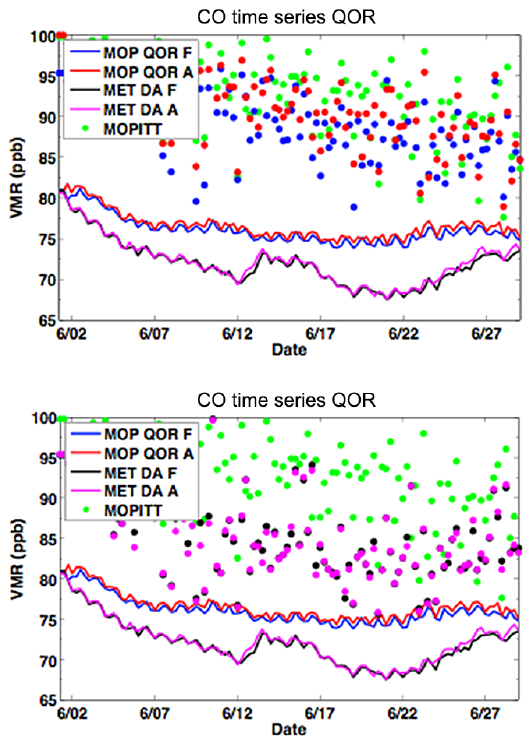
Figure 2. Time series of the domain average CO from the MOP QOR and MET DA experiments. The red and magenta dots show the domain average CO in retrieval space for the MOP QOR and MET DA analyses denoted in the legend by “A”. The blue and black dots show the domain average CO in retrieval space for the MOP QOR and MET DA forecasts denoted in the legend by “F”. The green dots show the domain average MOPITT CO retrievals. They are the same in both panels and are included for reference. The solid lines show the domain average CO in model space with the same color scheme as used for the analyses and forecasts in re- trieval space. The solid lines are the same in both panels are also included for